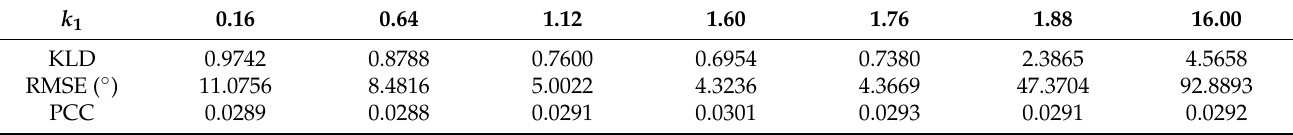
Table 2. Sensitivity analysis of parameter k 1 .